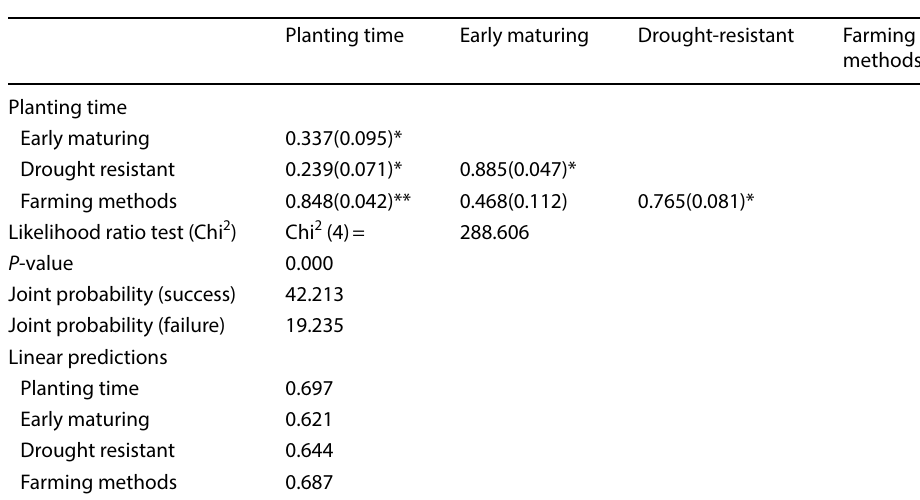
Table 6 Correlation matrix of the adaptation